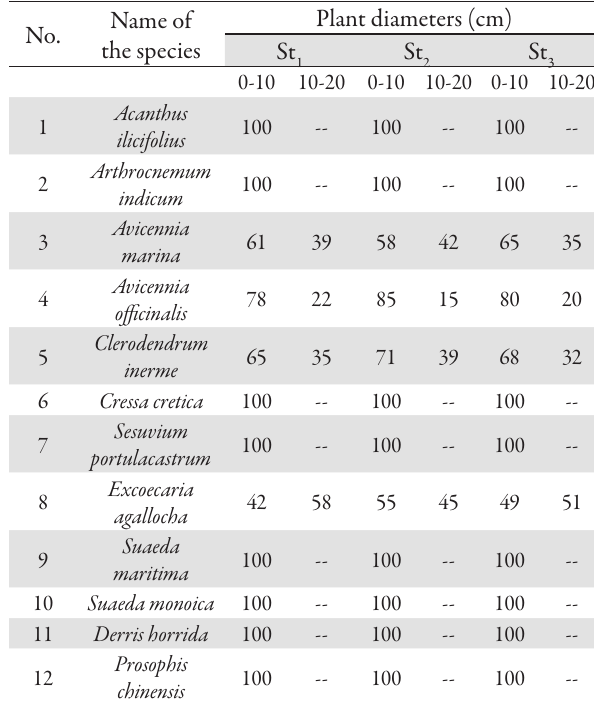
Tab. 2. Density of various plant populations estimated at various stations of Vainateyam and Vashista estuaries No.